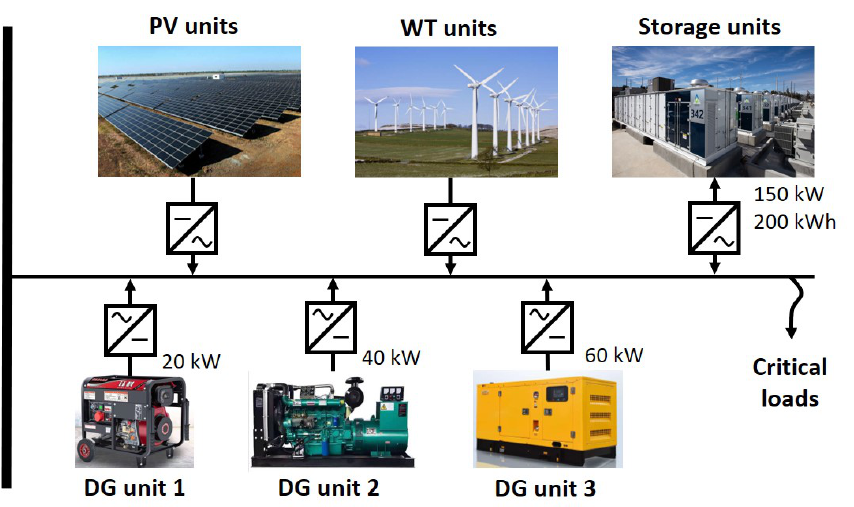
Figure 2. Scheme of a typical isolated microgrid including photovoltaic (PV) units, wind turbine (WT) units, storage units, and three different sets of diesel generators (DGs). The case is also studied in